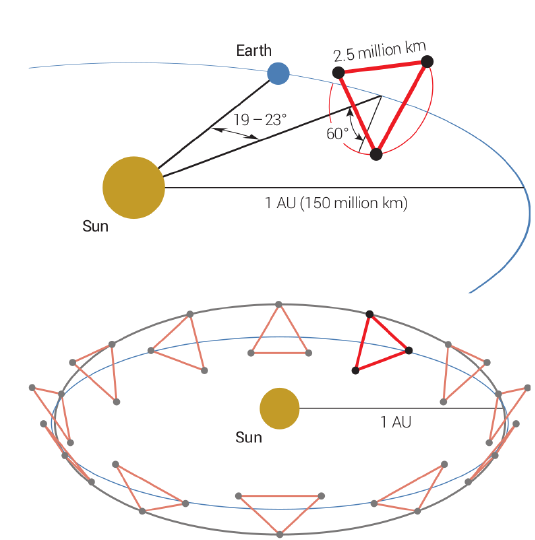
Figure 18: Visualization of the orbit of LISA. LISA is a space-based laser interferome- ter designed to measure gravitational waves with frequencies of about 10 − 2 Hz. The interferometer consists of three satellites that are orbiting the Earth in a triangle. Figure taken from Ref. [ 9 ]